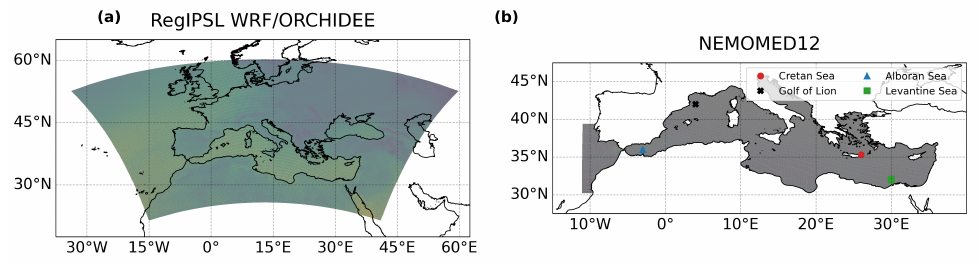
Figure 3. Domains of the WRF/ORCHIDEE simulation ( a ), and NEMO simulations ( b ). Both were run within the RegIPSL regional